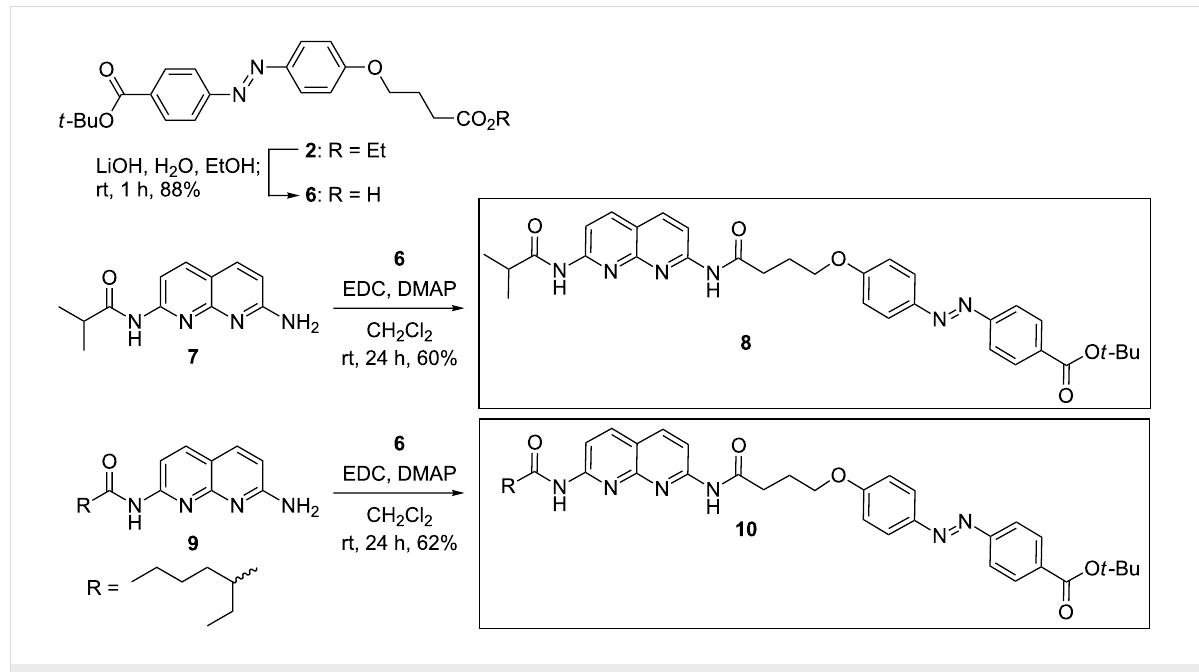
Scheme 2: Synthesis of azobenzene-dye-coupled DAN 8 and 10 .